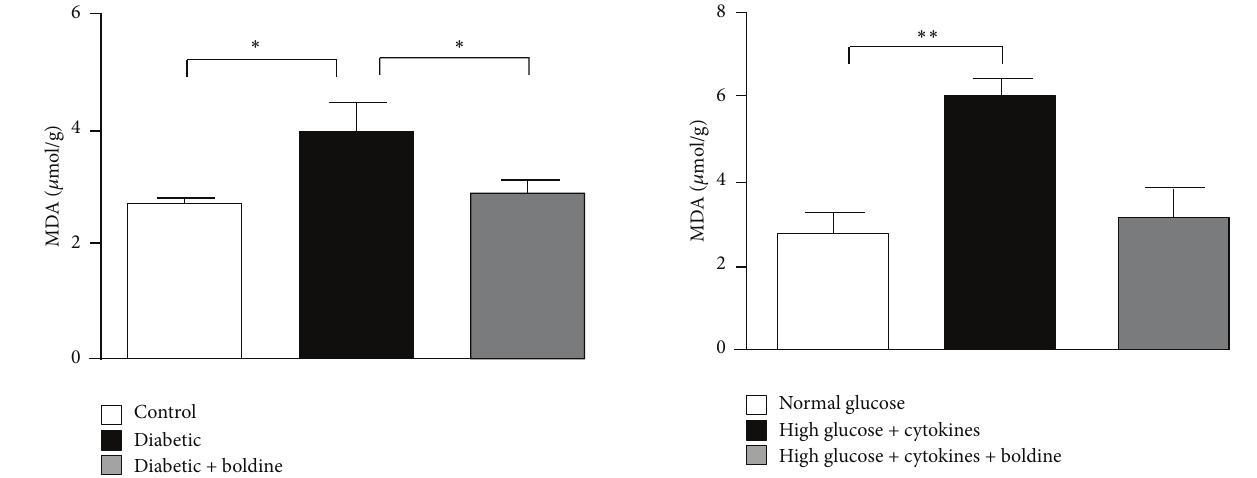
Figure 4: Boldine prevents lipid peroxidation in kidneys from diabetic rats. Graph showing levels of TBARS (MDA) in kidneys from control rats (white bar), diabetic rats (black bar), and diabetic rats treated with 50mg/Kg/day boldine (grey bar). Values are expressed as 𝜇 mol of MDA per g of renal tissue. Each bar represents the mean value ± SEM of tissue from 7 independent animals. ∗ 𝑃 ≤ 0.05 , using the one-way ANOVA test followed by Bonferroni’s post hoc test.